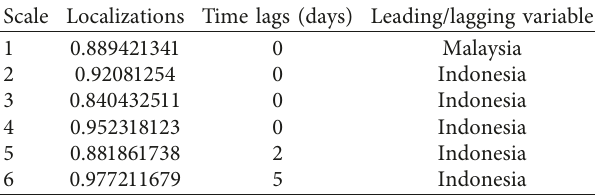
Table 5: Wavelet multiple cross correlations